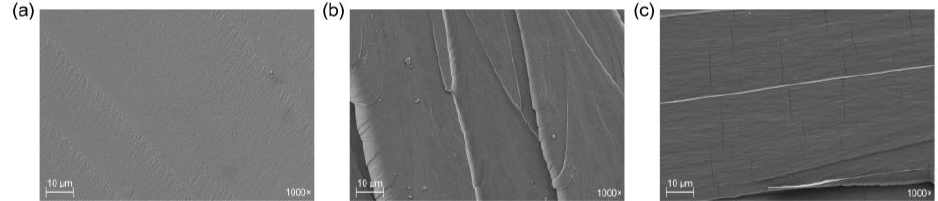
Figure 11. Field Emission Scanning Electron Microscopy (FESEM) images of the fracture surface of the samples at 1000×: ( a ) 100MNA, ( b ) 75MNA25MHO and ( c ) 50MNA50MHO.